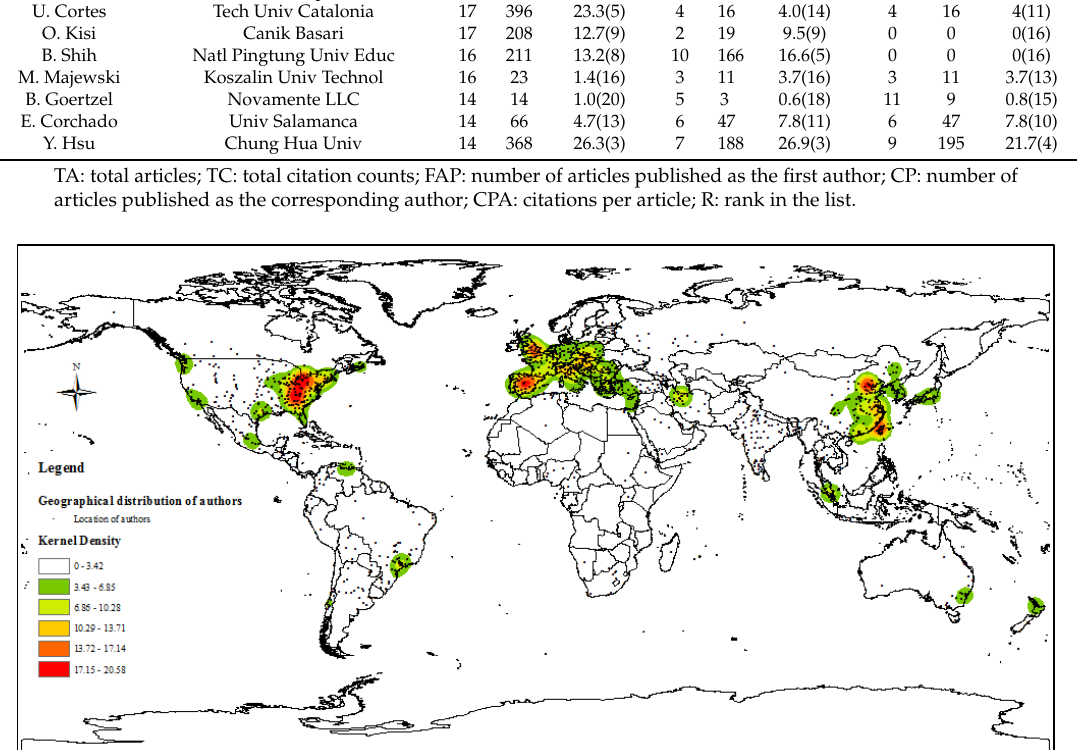
Figure 4. Relation between geographic distribution of authors and investment on R and D. Table 4. Twenty most productive countries/territories in artificial intelligence research. TA